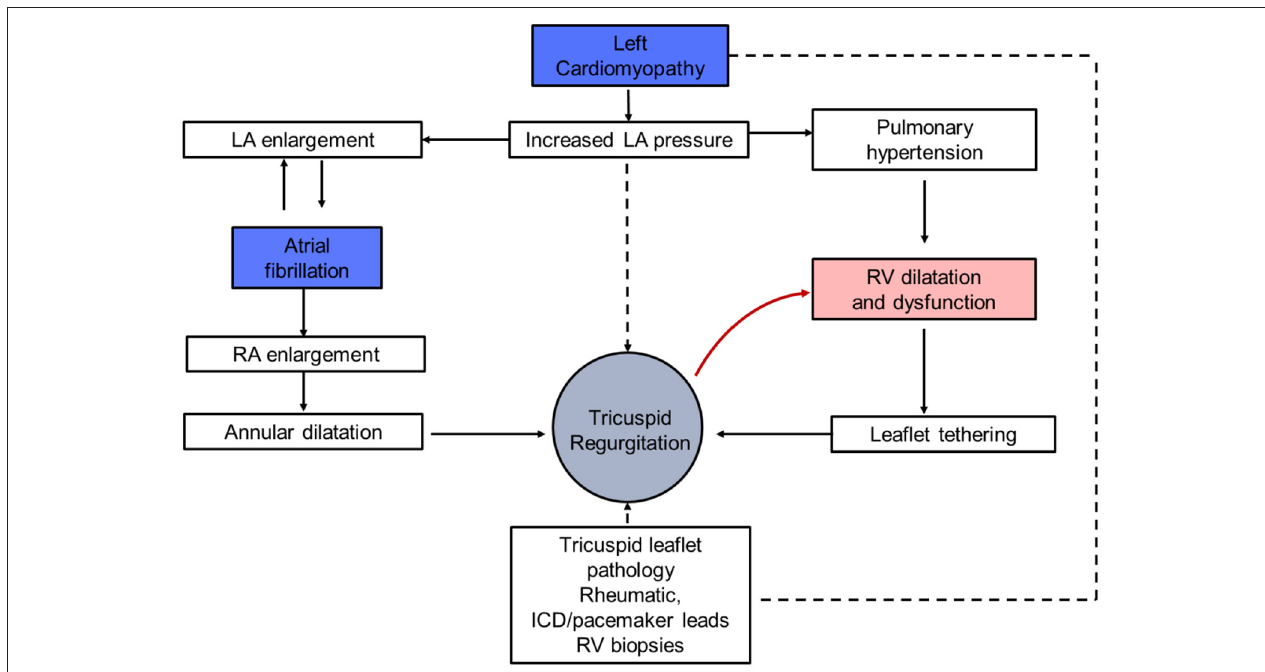
FIGURE 4 | Pathophysiology of tricuspid regurgitation and heart failure. LA, left atrium; RA, right atrium; RV, right ventricle; ICD, implantable cardioverter